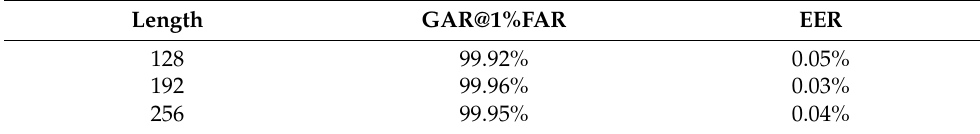
Table 6. Verification results from different users in data encryption and decryption.